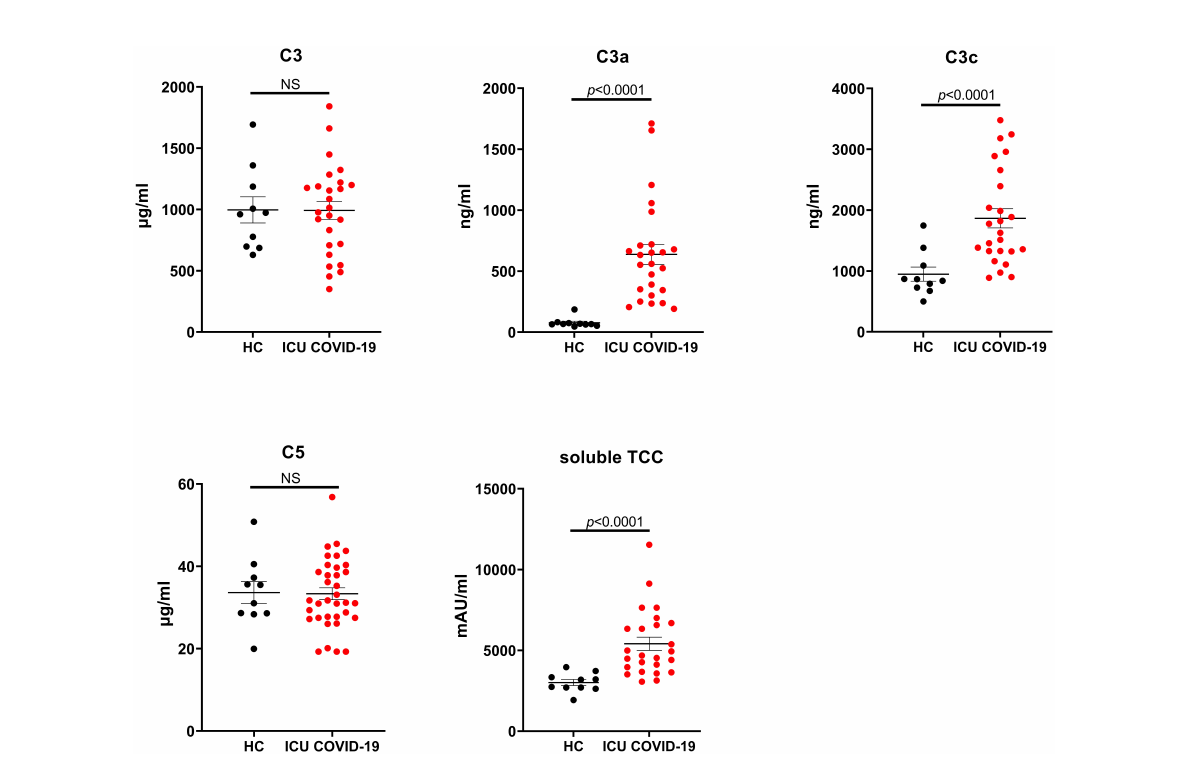
FIGURE 7 C3 and C5 consumption in COVID-19 patients. EDTA-plasma sample values for the markers C3, C3a, C3c, C5 and soluble TCC. Samples were analyzed using a serial dilution ranging from 1:500 to 1:64000 and data are represented as individual values and mean ± SEM. NS, non- signi fi cant; HC, healthy volunteers; ICU, intensive care unit; COVID-19, Corona Virus Disease